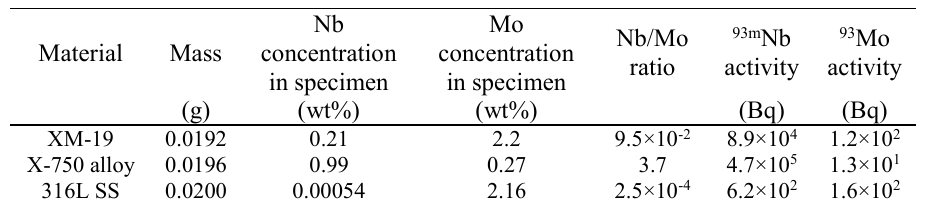
Table 3. Results of analysis.